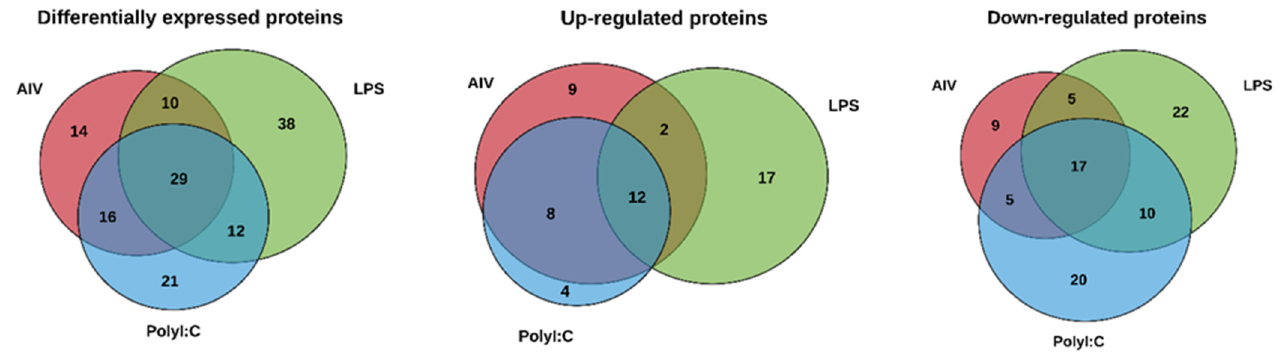
Figure 1. Volcano plots showing DE proteins of EVs from TOCs treated with ( a ) AIV, ( b ) LPS, and ( c ) polyI:C. The horizontal dotted line represents the p -value < 0.05 threshold. Up-regulated proteins are represented by green data points and down-regulated proteins are represented by red data points. The vertical dotted lines represent the abundance ratio ≥ 2-fold change threshold. Lists of the up- and down-regulated proteins for AIV, LPS, and polyI:C treatment groups are shown in Tables 2 and 3, respectively.